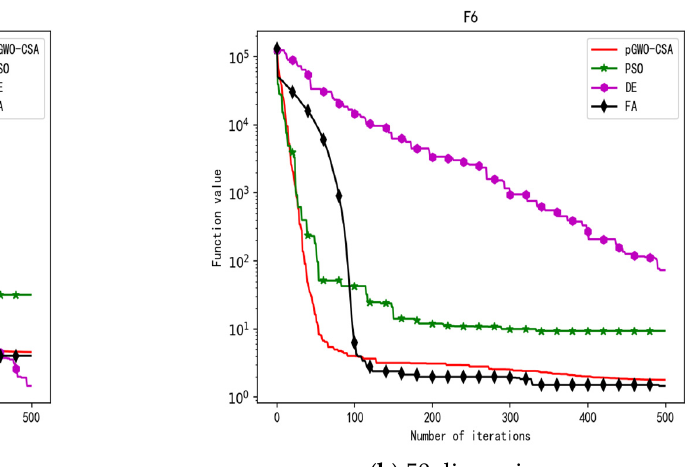
Figure 9. Convergence curve of test function F5.